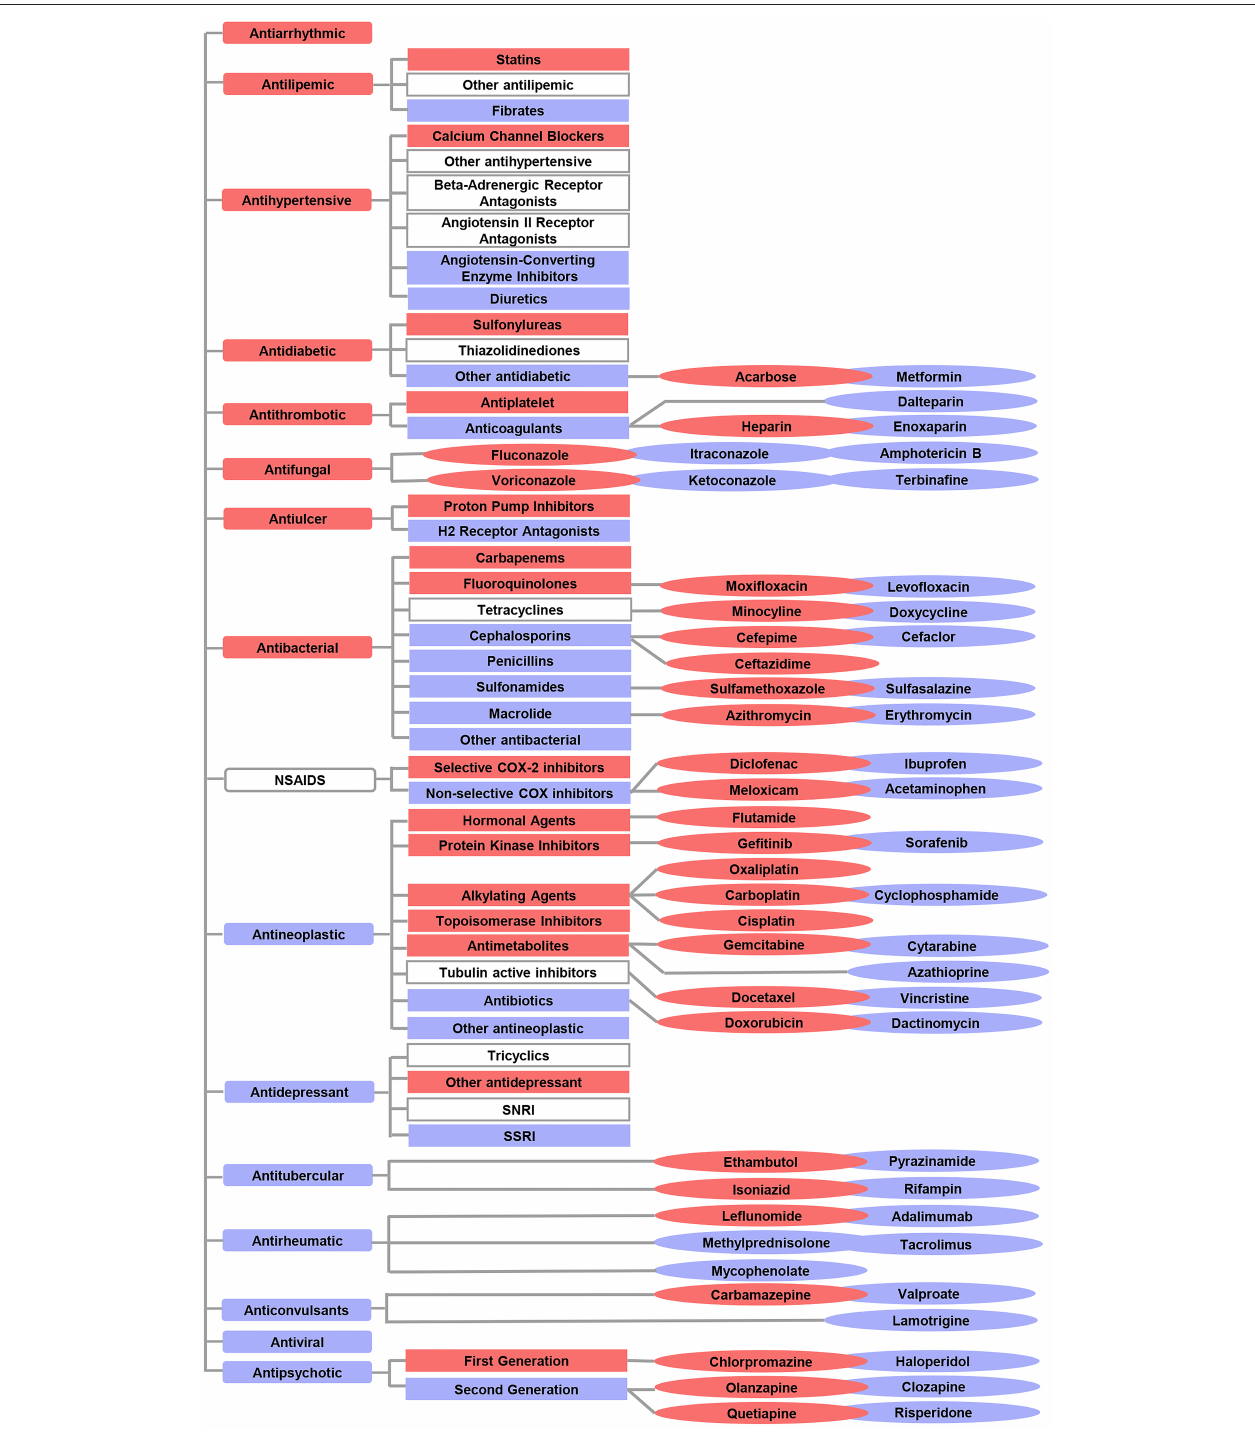
FIGURE 4 | Overview of the differential risks of drugs with known hepatotoxicity. The red color indicates a high correlation with the risk of L-ADR in older adults, whereas the blue color indicates a low correlation with the risk of L-ADR in older adults. The symbols without color filling indicate drug categories or subcategories which were not identified with differential risks. indicated drug categories; indicated subcategories; indicated